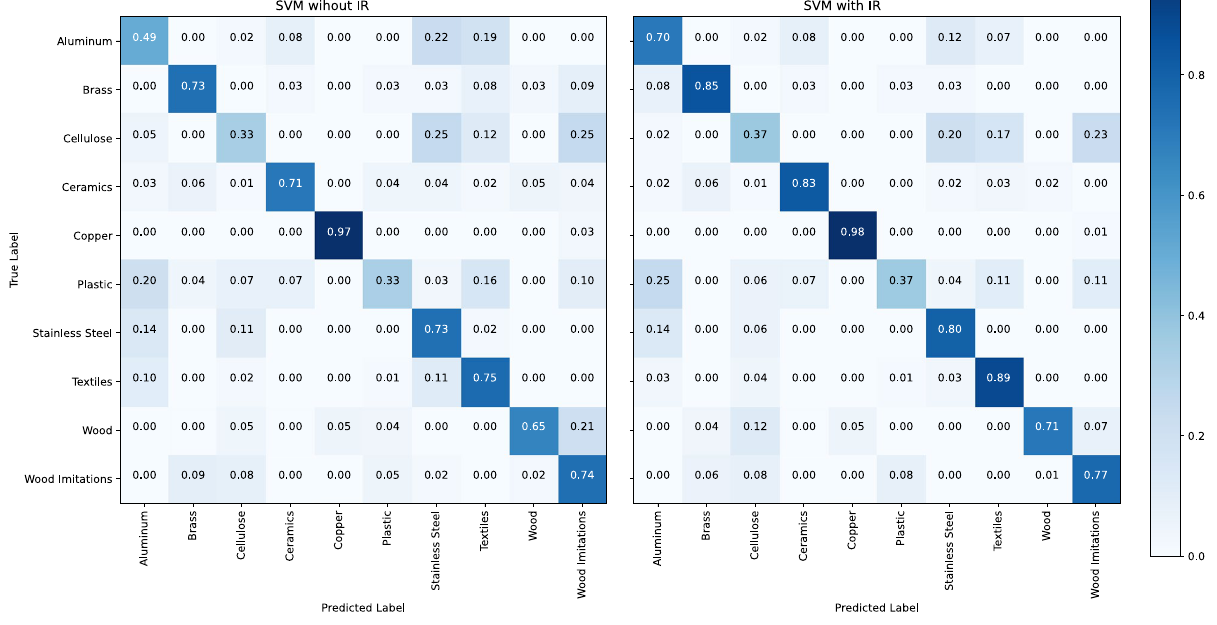
Model Precision Accuracy F1-Score Rel. Time